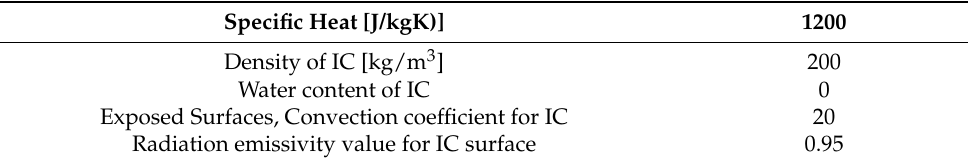
Table 2. Thermal properties of intumescent coating (IC) [21].